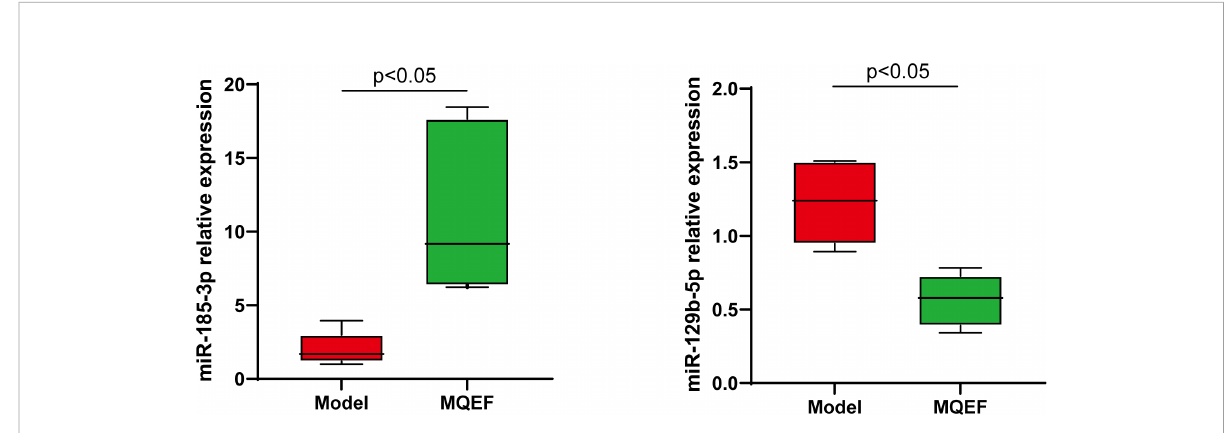
FIGURE 9 RT-QPCR analysis of bone marrow exosome miRNA, and the difference was signi fi cant (P <